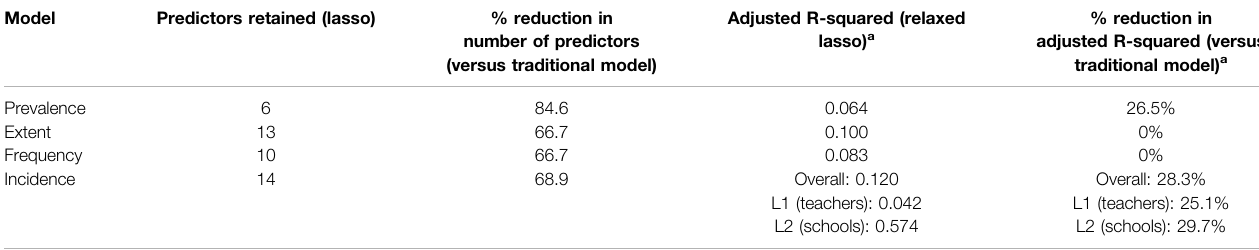
TABLE 2 | Comparison of lasso models to traditional models.